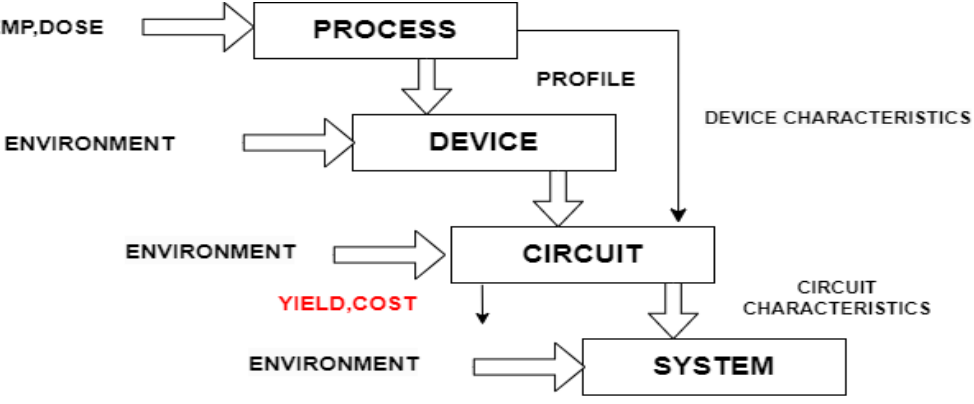
Figure 3. Relationship between system performance, device specifications, and processing.